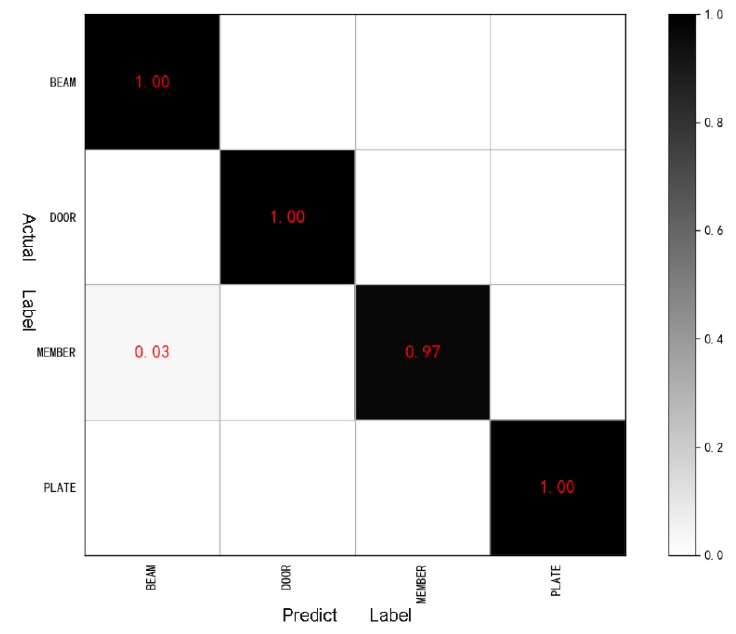
Figure 7. The confusion matrix corresponding to the optimal hyperparameter.